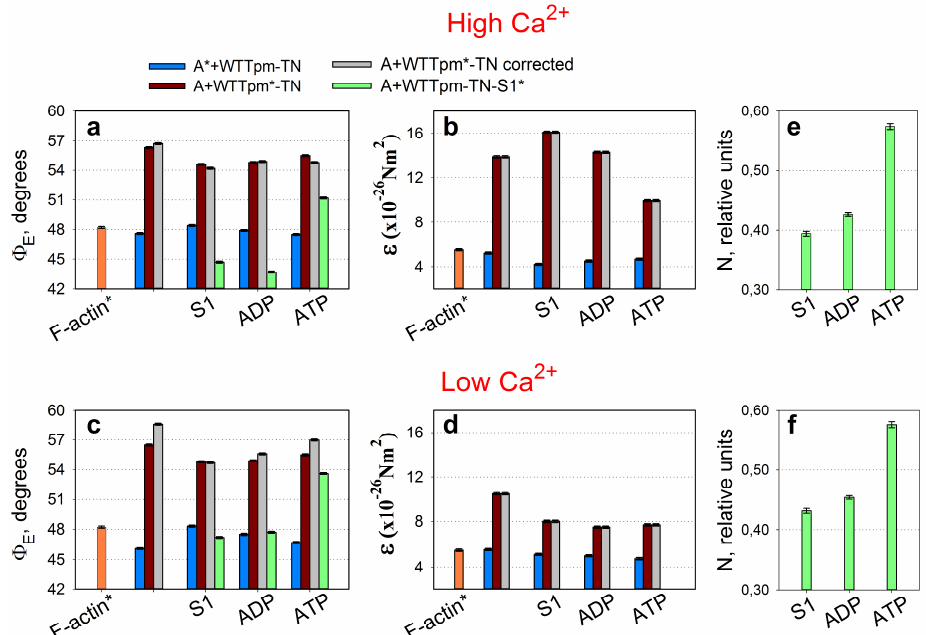
Figure 2. The values for the angle Φ E ( a , c ) and for the bending stiffness ε ( b , d ) determined on the basis of analysis of the polarized fluorescence from FITC-phalloidin bound to F-actin (A*, FITC-actin) and from 5-IAF bound to Cys190 of wild-type tropomyosin (WTTpm*, AF-WTTpm) and the values of the parameters Φ E ( a , c ) and N ( e , f ) of the polarized fluorescence from 1,5-IAEDANS bound to Cys707 of myosin SH1 helix (S1*, AEDANS-S1) revealed in ghost fibers at simulating various steps of the ATPase cycle at high ( a , b , e ) and low Ca 2+ ( c , d , f ). Φ E is the angle between the emission dipole of the probe and the filament axis; ε is the bending stiffness and N is a number of disorderly oriented fluorophores. Calculations of the Φ E , ε , and N values, the preparation of the fibers, their composition, and the conditions of the experiments are described in Section 4. The red and blue columns show data for the “pure” FITC-actin filaments and those decorated by Tpm-TN, respectively. Brown and grey columns show data for the filaments decorated by AF-Tpm-TN. Green columns show data for the thin filaments decorated by AEDANS-S1. The data represent means of 8–10 ghost fibers for each experimental condition. Φ E , ε , and N values are significantly altered by nucleotides ( p < 0.05). Error bars indicate ±